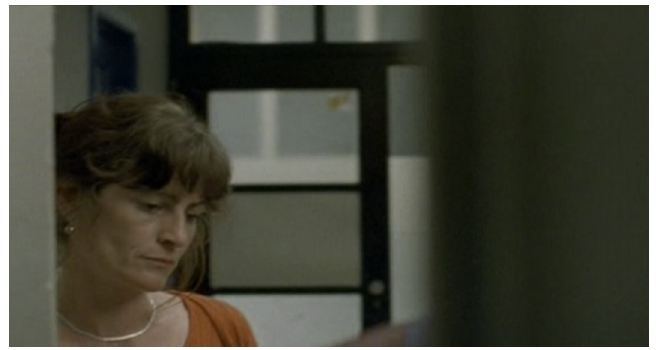
Figure 2. Opening Sequence of Le Fils .